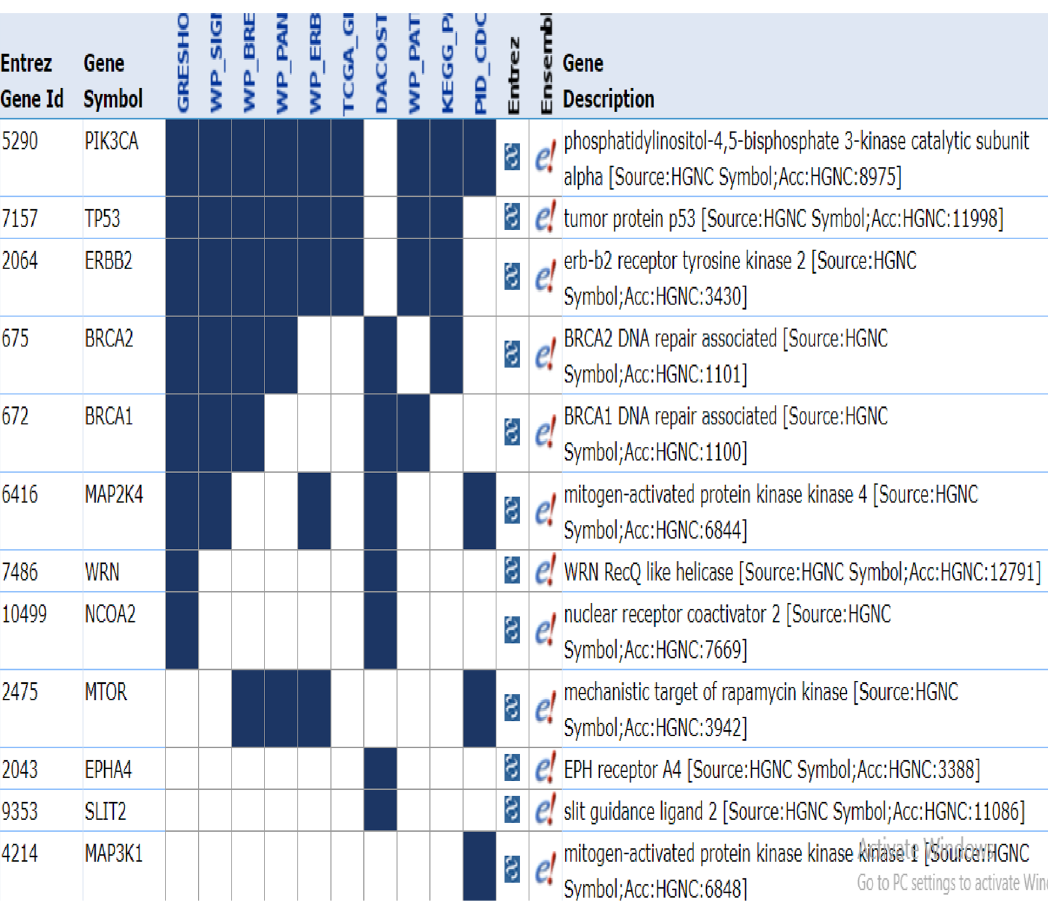
Figure 3. Proposed driver genes are compared to several benchmarks at the same time.